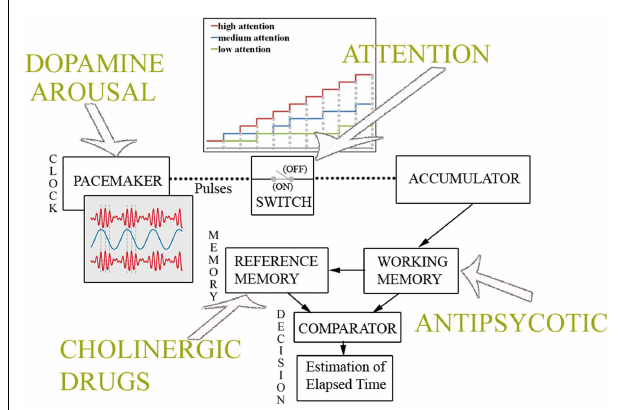
FIGURE 1 | Cognitive model of time perception . Information processing model of interval timing as specified by the Scalar ExpectancyTheory. As depicted in top panel, the pacemaker speed is affected by dopamine levels and arousal, while attention to time modulates the switch.When attention is high, the estimate of elapsed time grows according to the clock rate, while if attentional resources are overloaded (medium, low attention to time), the switch fluctuates between a closed and an open state, resulting in the underestimation of physical duration. As shown in bottom panel, cholinergic drugs induce changes in temporal memories, whereas antipsychotic medications affect the working memory processes involved in the estimation of elapsed